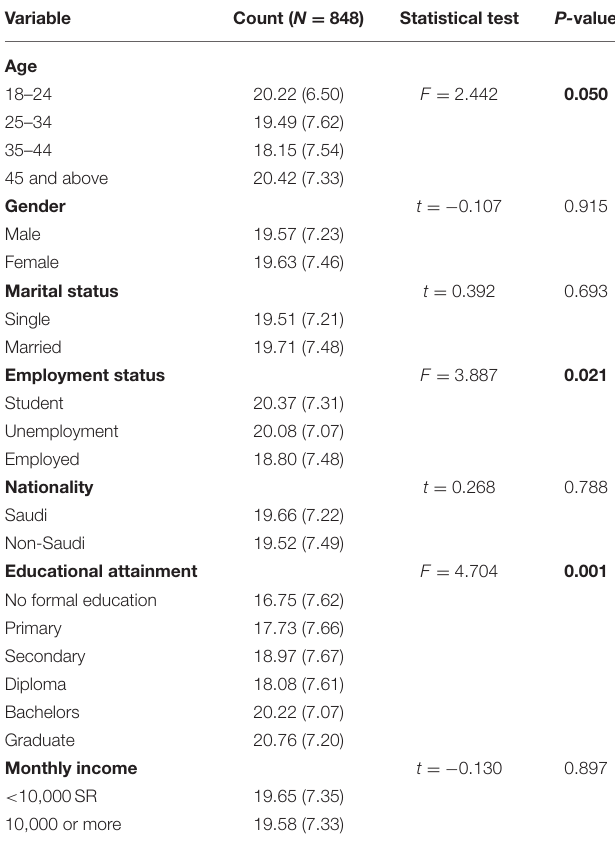
(COVID-19) scale (FCoV-19S).